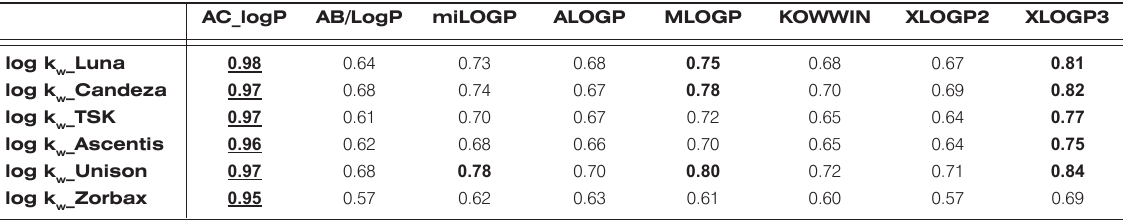
AC_logP AB/LogP miLOGP ALOGP MLOGP